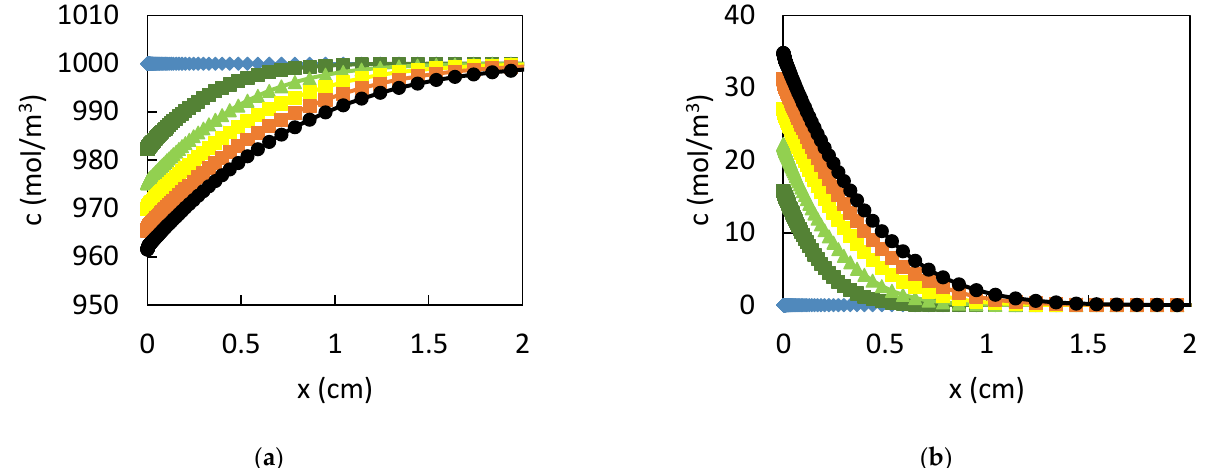
Figure 10. Evolution of ( a ) the protons and ( b ) H 2 concentration in an electrolyte of 1000 mol/m 3 HCl and of size L = 10 cm with an initial CPL of 100 µm and a fixed porosity of 0.9. The first 2 cm of the electrolyte are presented for different times t = 0 s (light blue), 3600 s (dark green) 7200 s (green), 10,800 s (yellow), 14,400 s (orange), and 18,000 s (black).